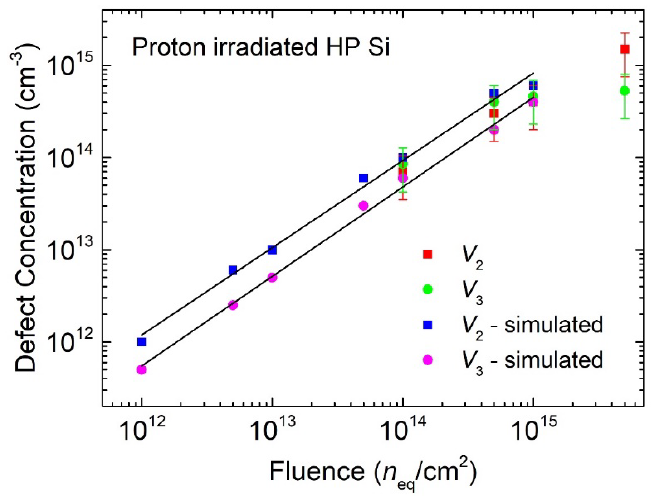
Figure 7. The concentrations of V 2 and V 3 formed under irradiation of HPSi samples with 23-MeV protons as a function of the fluence rising from 1 × 10 12 to 5 × 10 15 n eq /cm 2 . For the fluence up to 5 × 10 13 n eq /cm 2 , only the [ V 2 ] and [ V 3 ] simulated values obtained by NIEL calculations are taken [1]. For the fluence ranging from 1 × 10 14 to 1 × 10 15 n eq /cm 2 , both the simulated and experimental values of [ V 2 ] and [ V 3 ] are used to determine the trend lines by linear regression. For the fluence of 5 × 10 15 n eq /cm 2 , only the [ V 2 ] and [ V 3 ] experimental values are presented.